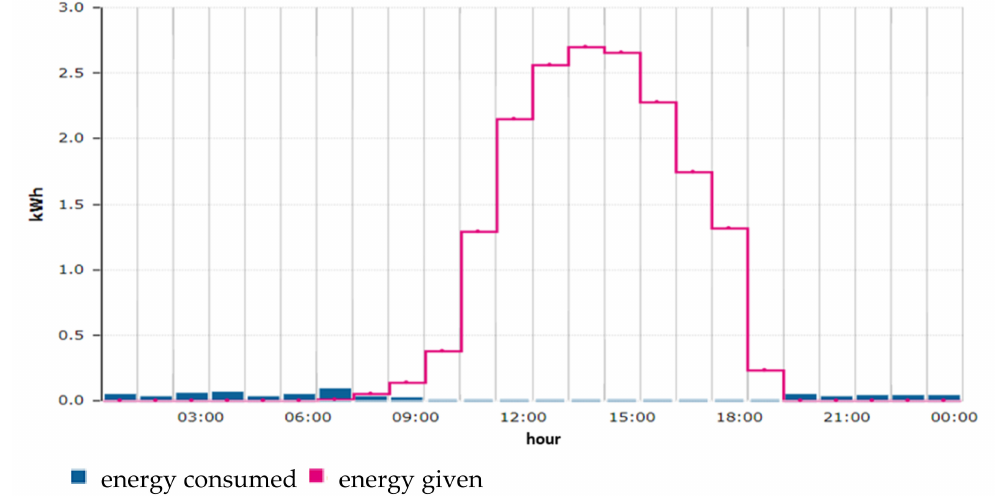
Figure 10. Graph of energy used and fed into the network during the day from a large-scale installation. Source: own